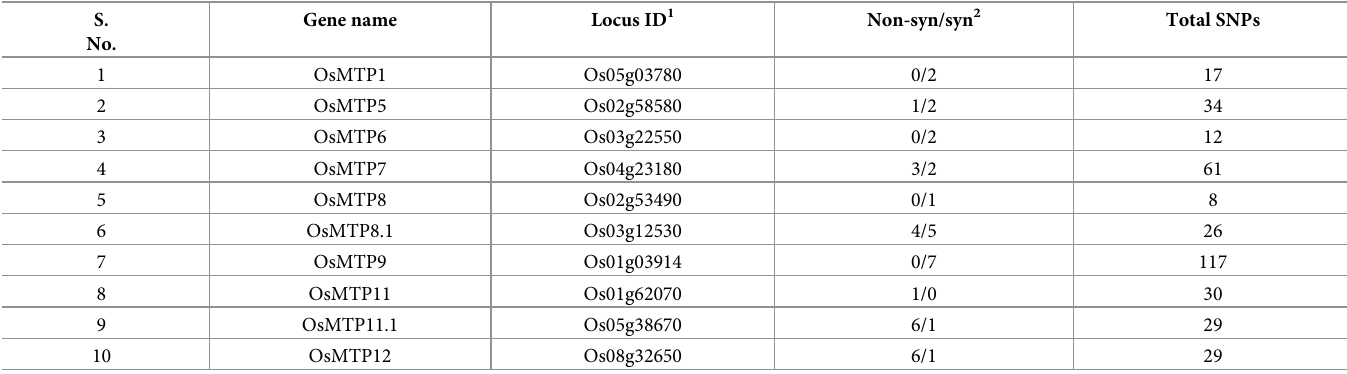
Table 2. Single nucleotide polymorphism (SNP) for metal tolerance protein genes in three thousand rice genotypes. S. No.